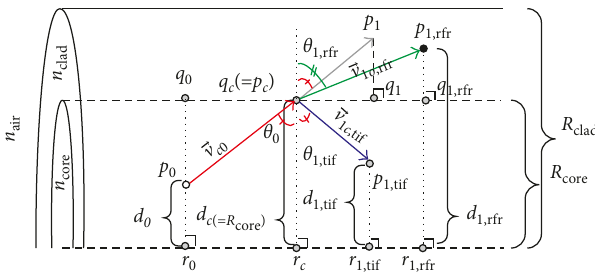
Figure 9: Schematic view of ray-tracing version refraction model.